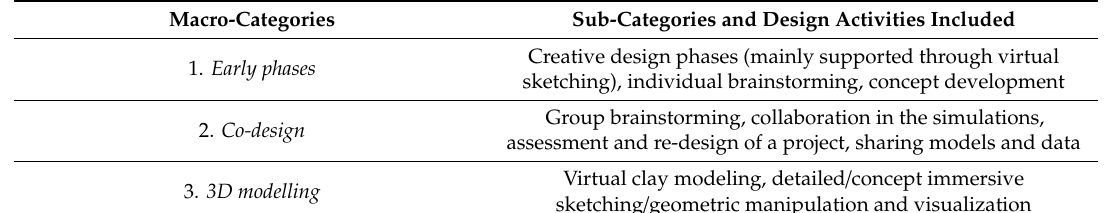
Table 2. Macro-categories of the functions supported by VR